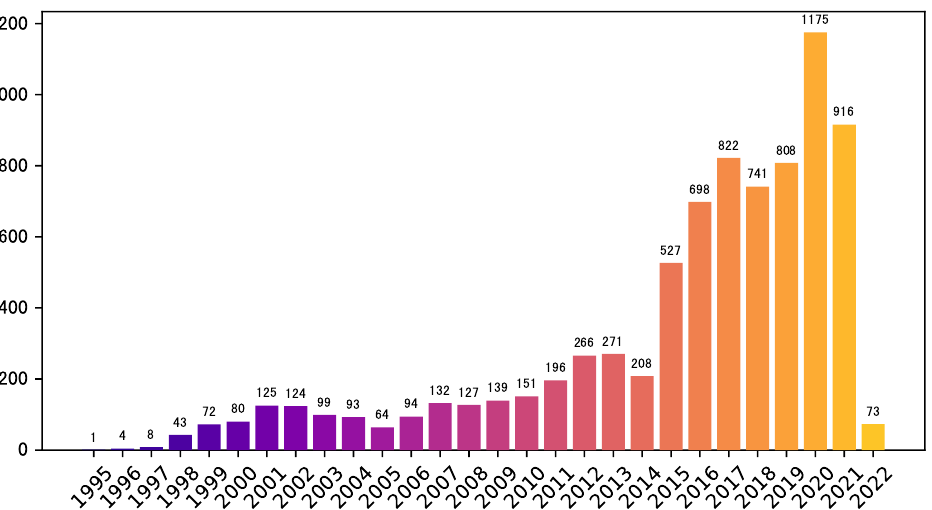
Figure 4. Number of patent applications per year. The number of patent applications has generally been increasing. The apparent decline in 2021 and 2022 could have been due to the delays from the application dates to the disclosure dates of the patents’